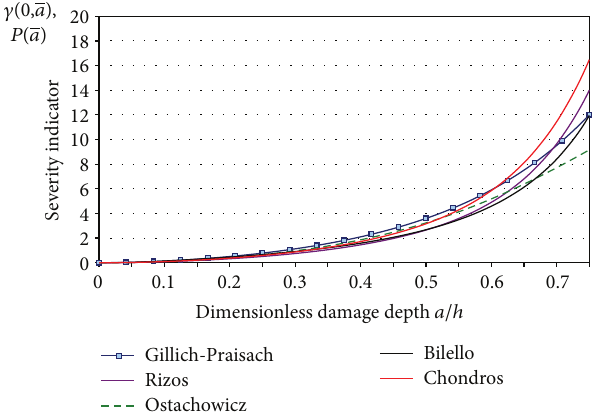
Figure 3: Comparison of relations used to express the rigidity loss due to damage versus the dimensionless damage